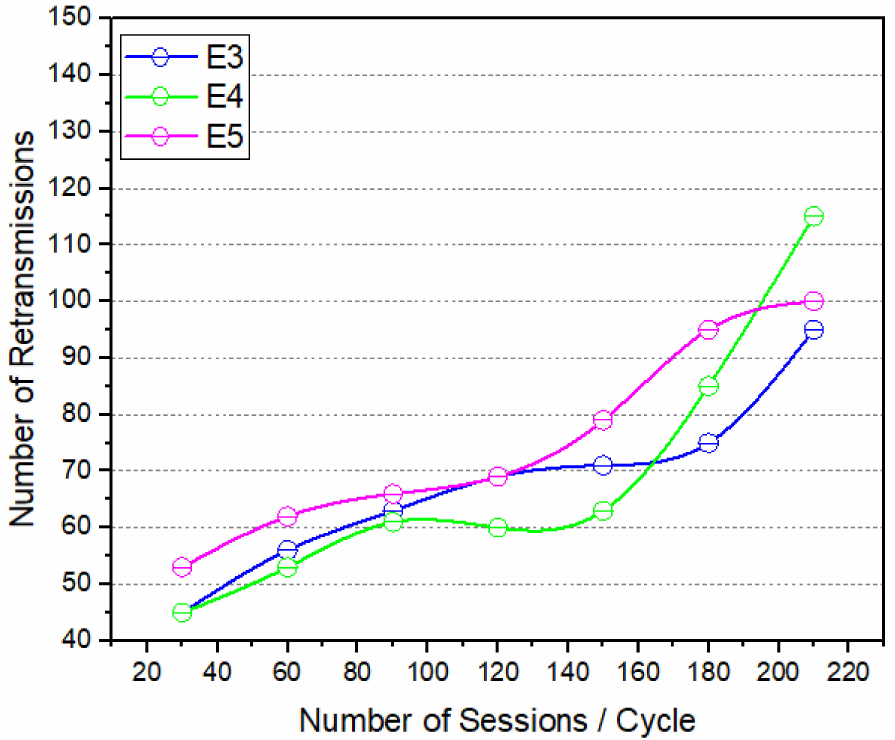
Figure 11. Total number of